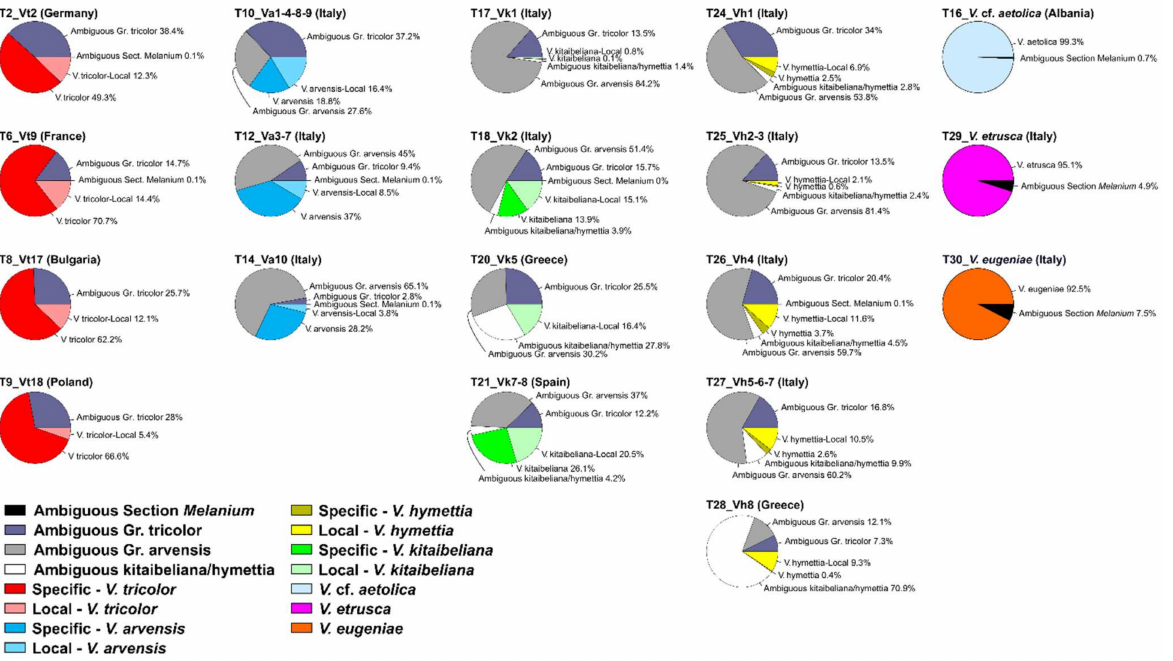
Figure 2. Proportional occurrence of the different 5S-IGS sequence classes (sequence abundance ≥ 5) in the investigated